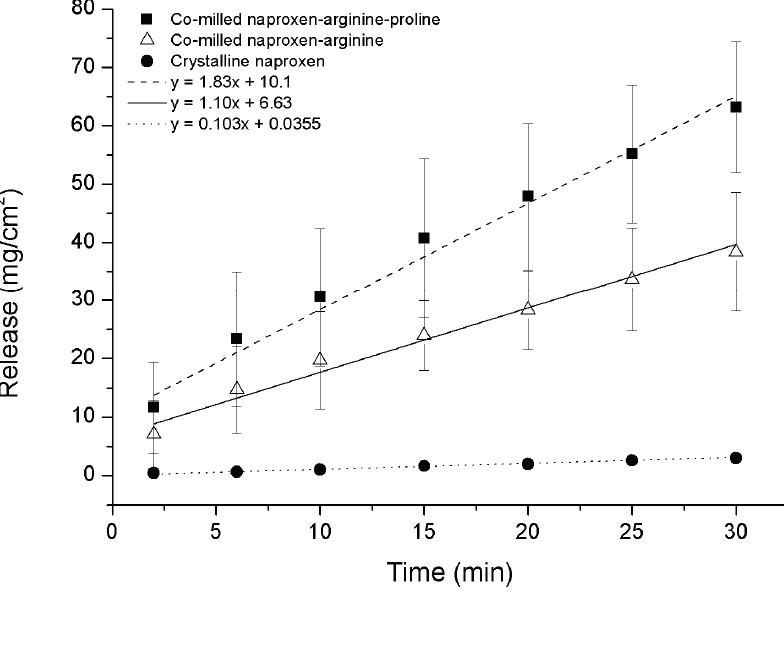
Figure 9. Intrinsic dissolution profiles of crystalline NAP, co-amorphous NAP–ARG and co-amorphous NAP–ARG–PRO ( n = 3, mean ± standard